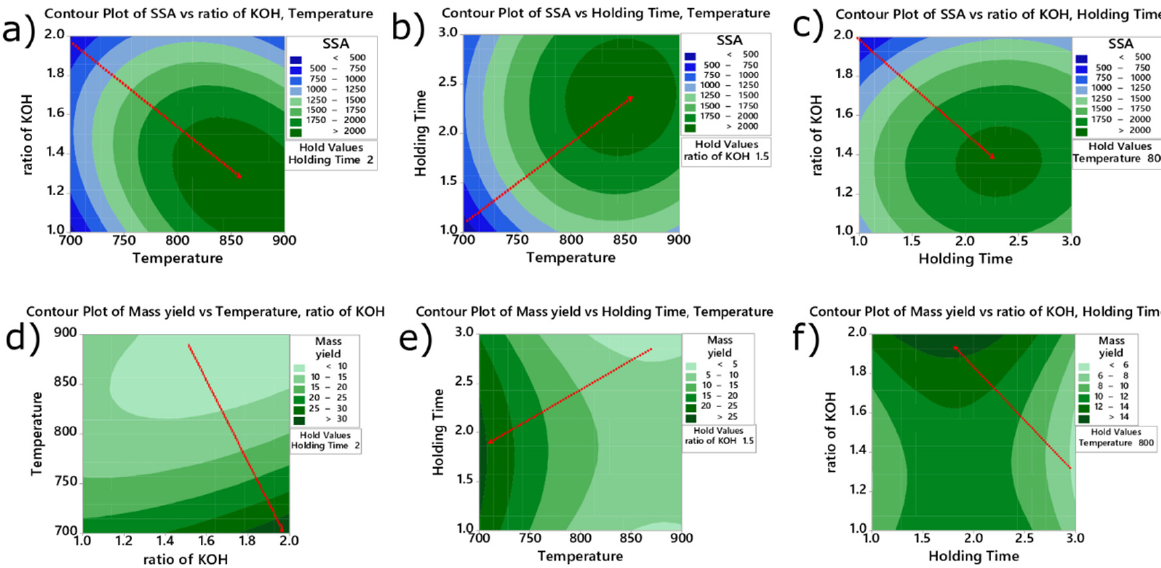
Figure 2. Contour plots of SSA and mass yielding versus each pair of parameters. Contour Plot of SSA vs ratio of KOH, Temperature ( a ); Contour Plot of SSA vs Holding Time, Temperature ( b ); Contour Plot of SSA vs ratio of KOH, Holding ( c ); Contour Plot of Mass yield vs Temperature, ratio of KOH ( d ); Contour Plot of Mass yield vs Holding Time, Temperature ( e ); Contour Plot of Mass yield vs ratio of KOH, Holding Time ( f ).